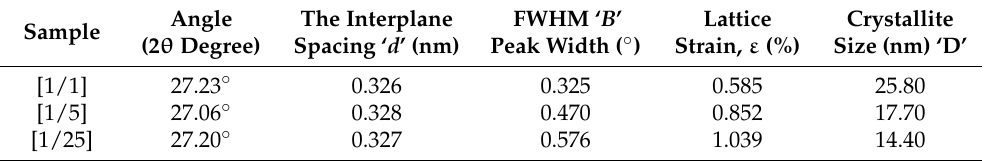
Table 4. CdS thin film structural